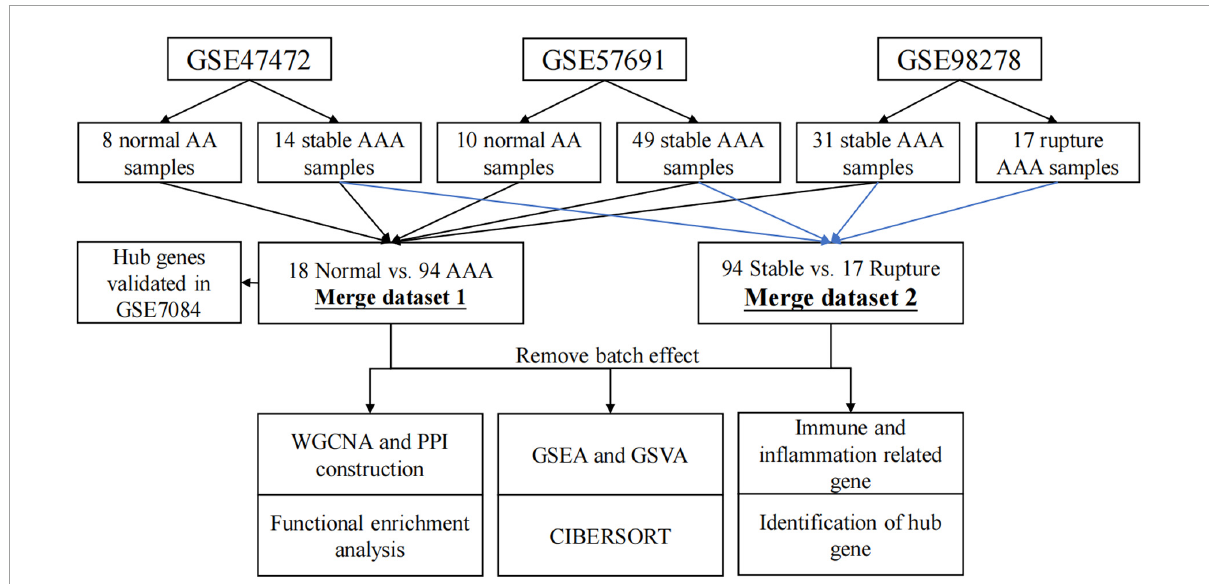
FIGURE1 Flow chart diagram for analysis process in this study. WGCNA, weighted gene correlation network analysis; PPI, protein–protein interaction; GSEA, gene set enrichment analysis; GSVA, gene set variation